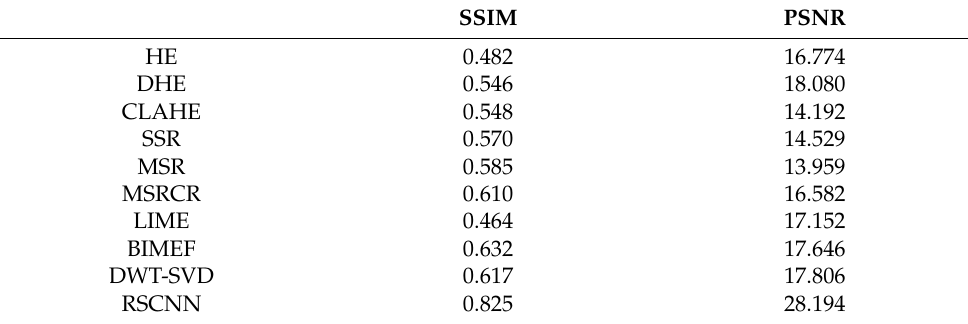
Table 2. Average structural similarity indexes (SSIMs) and peak signal-to-noise ratios (PSNRs) of the testing results after